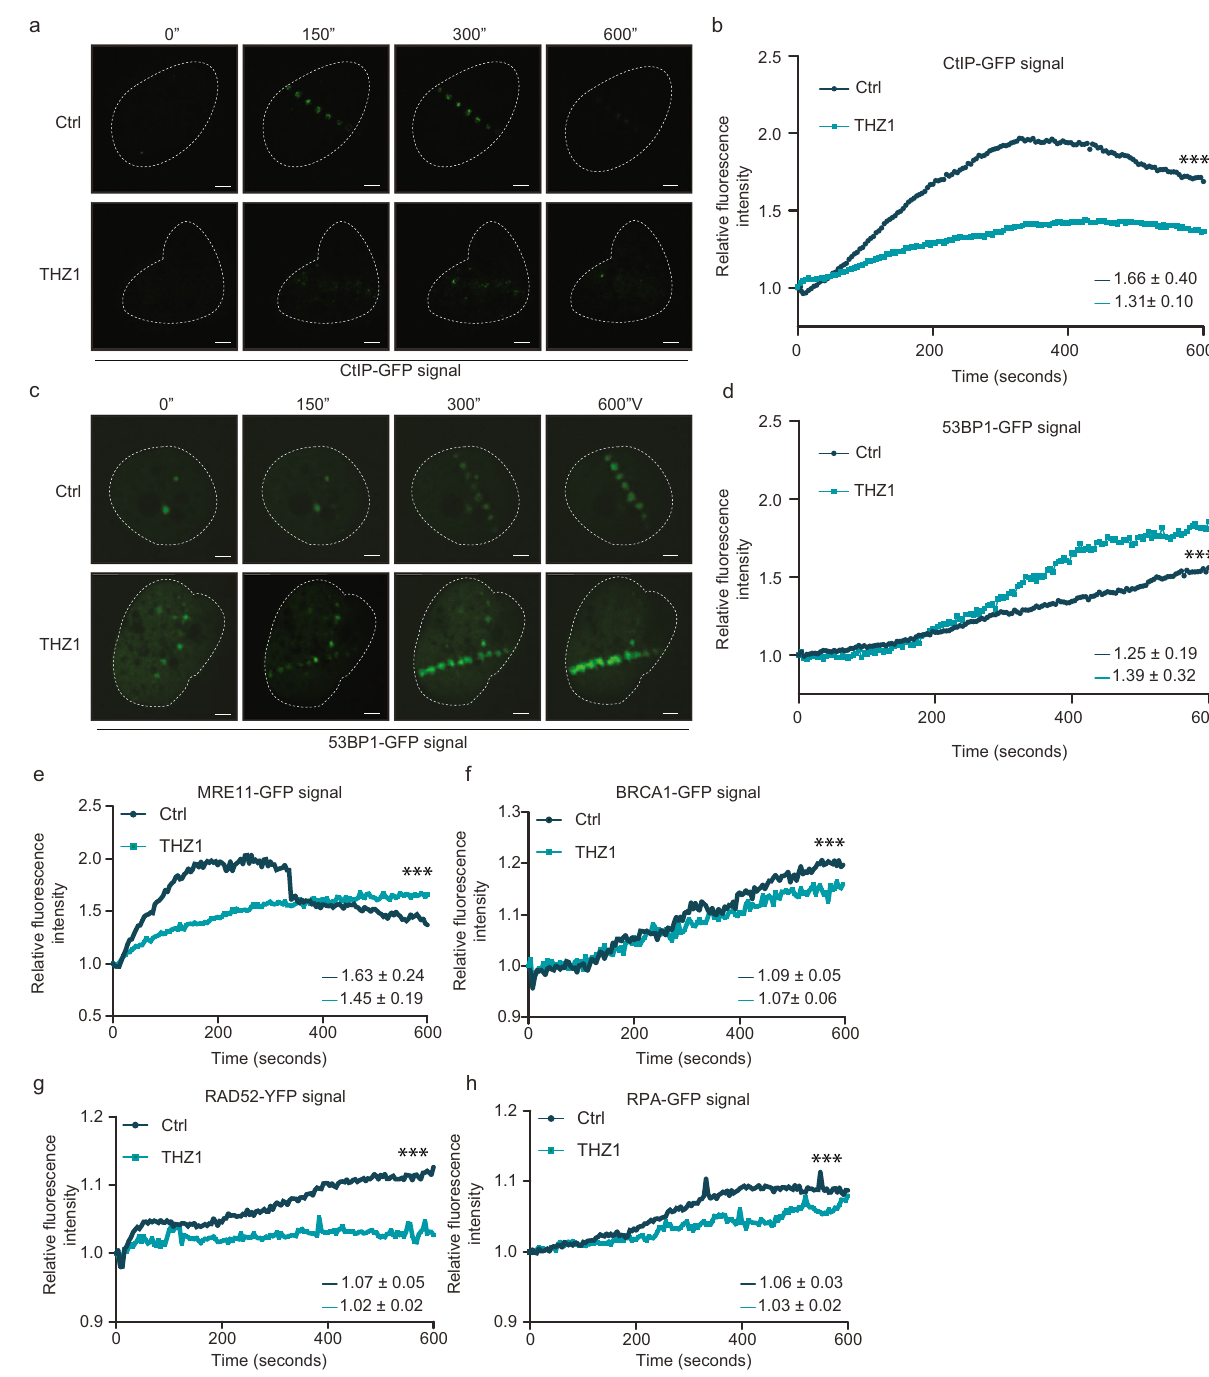
Fig. 4 | Inhibition of RNAPII impairs DDR protein recruitment to DSBs. a Representative time-lapse images of CtIP-GFP recruitment to DNA damage in RNAPII -inhibited (THZ1, 1 µ M during 2h) and DMSO as control during 600s post microlaser irradiation in U2OS cells. n =3 biologically independent